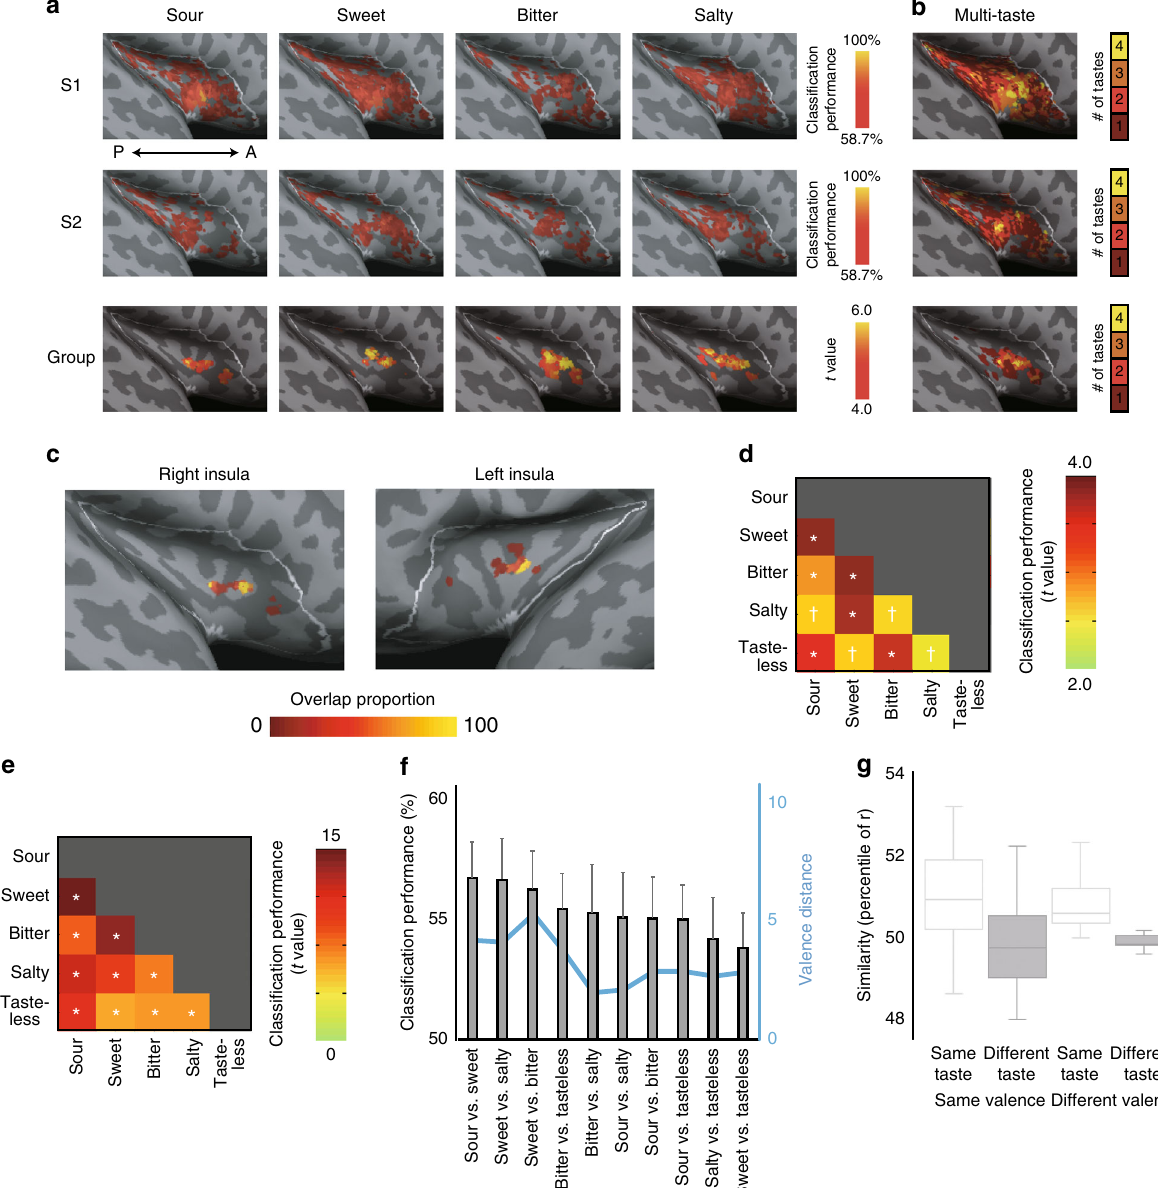
Fig. 2 Multivoxel pattern analysis of taste-speci fi c tuning in the insula. a Upper two rows indicate discriminability maps for sour, sweet, bitter, and salty stimuli of individual subjects (same as in Fig. 1a). Discriminability map indicates regions in which the average pairwise classi fi cation performance for a speci fi c taste vs. each other taste was signi fi cantly higher than chance (50%). The linear discriminability searchlight maps (searchlight radius = 4 mm) were thresholded at p < 0.05 (uncorrected), which corresponded to 58.7% discrimination (chance level: 50%). The third row indicates group multi-taste- coding results ( n = 20 participants) in which subjects were treated as a random effect, thresholded at FWE < 5% (small volume correction). A: anterior, P: posterior. b The number of taste types represented in the insula. Multi-taste population codes discriminated four basic tastes in the anterior and middle insula. c Overlap of four taste discriminability maps (each satis fi es FWE < 5%) by leave-one-subject-out procedure. Color code indicates the percentage among the 20 leave-one-subject-out maps that was signi fi cant. d Representational dissimilarity matrix showing the pattern discriminability for each taste pair based on fMRI activity patterns of the right and left insula. e Representational dissimilarity matrix showing the pattern discriminability for each taste pair based on positive and negative valence ratings. f Classi fi cation performance for each taste pair compared with valence distance suggests discrimination of taste type separate from valence. Error bars indicate SE. g Repeated-measures ANOVA with taste type and valence as factors and trial fMRI activity pattern similarity (measured as correlations) as dependent variable. A main effect of taste type, but not valence nor interaction, demonstrates insular taste-type patterns do not re fl ect differences in experienced valence. Boxes represent the median and 25th/75th percentiles and whiskers represent the minimum and maximum. ✝ p < 0.05 uncorrected, * p < 0.05 after Bonferroni correction for multiple comparisons (FWE <